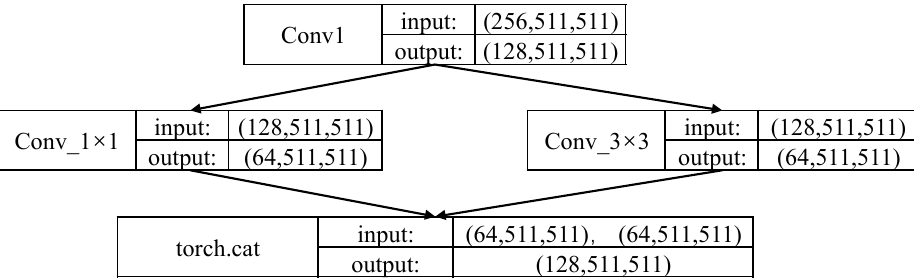
Figure 7. Architecture of the fire module.